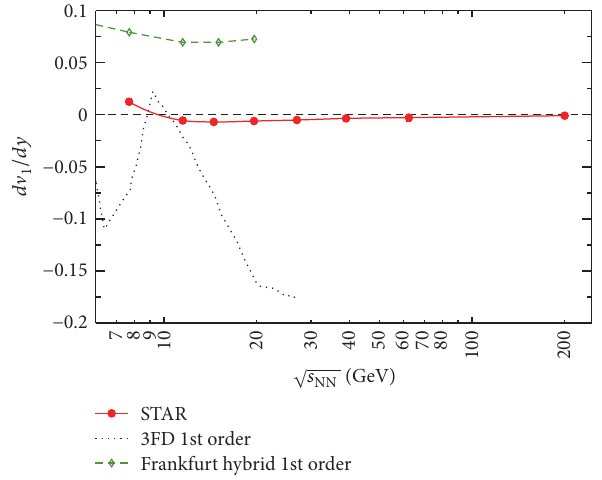
Figure 14: Beam energy dependence of directed flow slope for protons in 10–40% centrality Au+Au from the STAR experiment, compared with recent hybrid [95] and 3FD [94] model calculations. All the experimental data are from [47] except for one energy point, √𝑠 = 14.5 GeV [90], which should be considered a preliminary NN